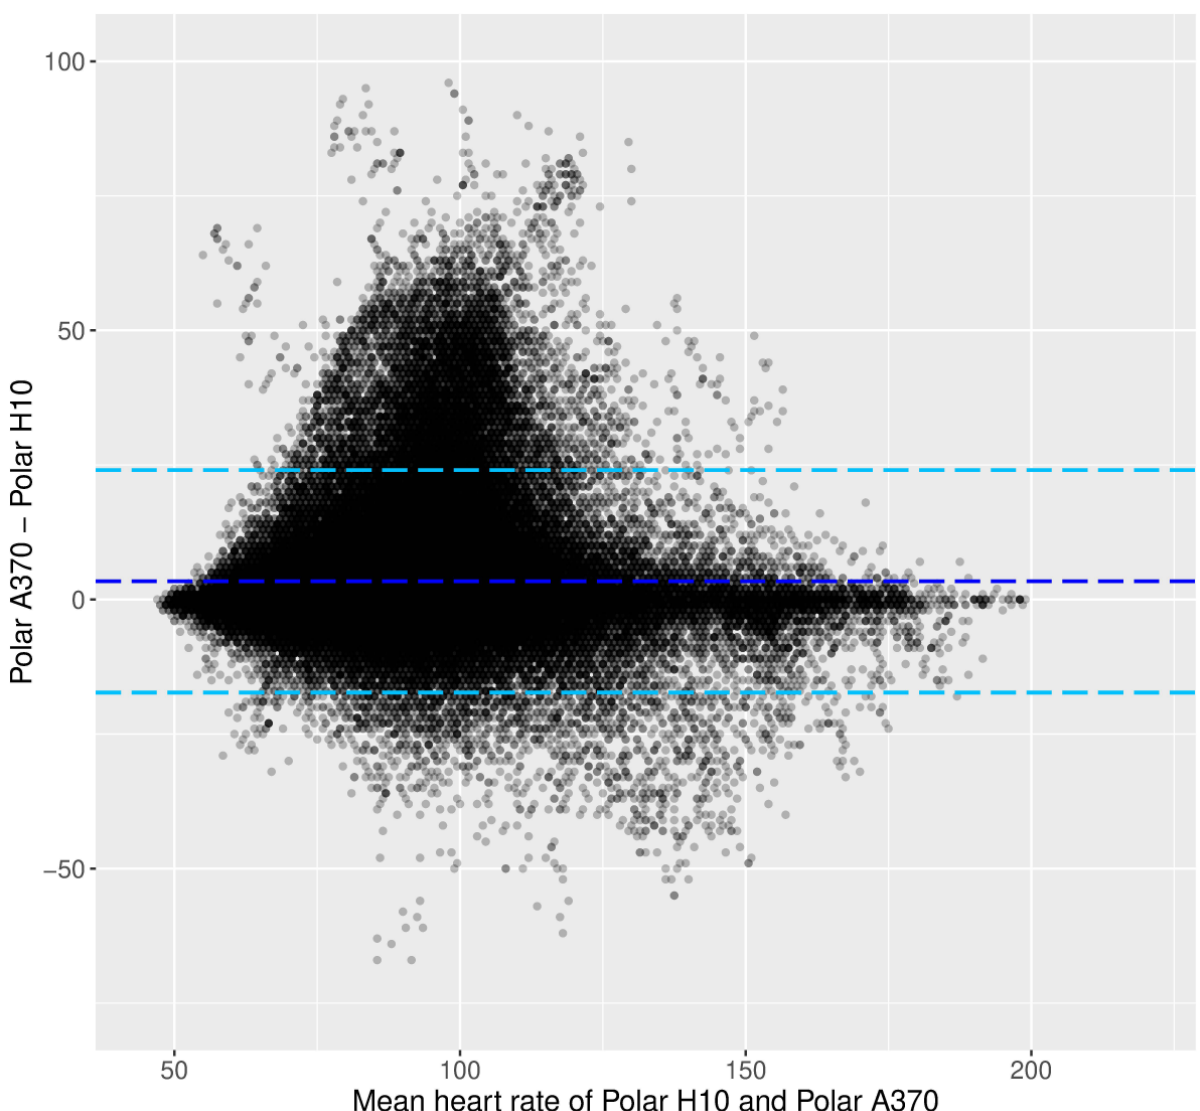
Figure 8. Free-living phase: Bland-Altman plot between the heart rate data from the Polar H10 and the Polar A370. Light blue dotted lines show the limits of agreement, and the dark blue dotted line shows the mean of the difference. HR: heart